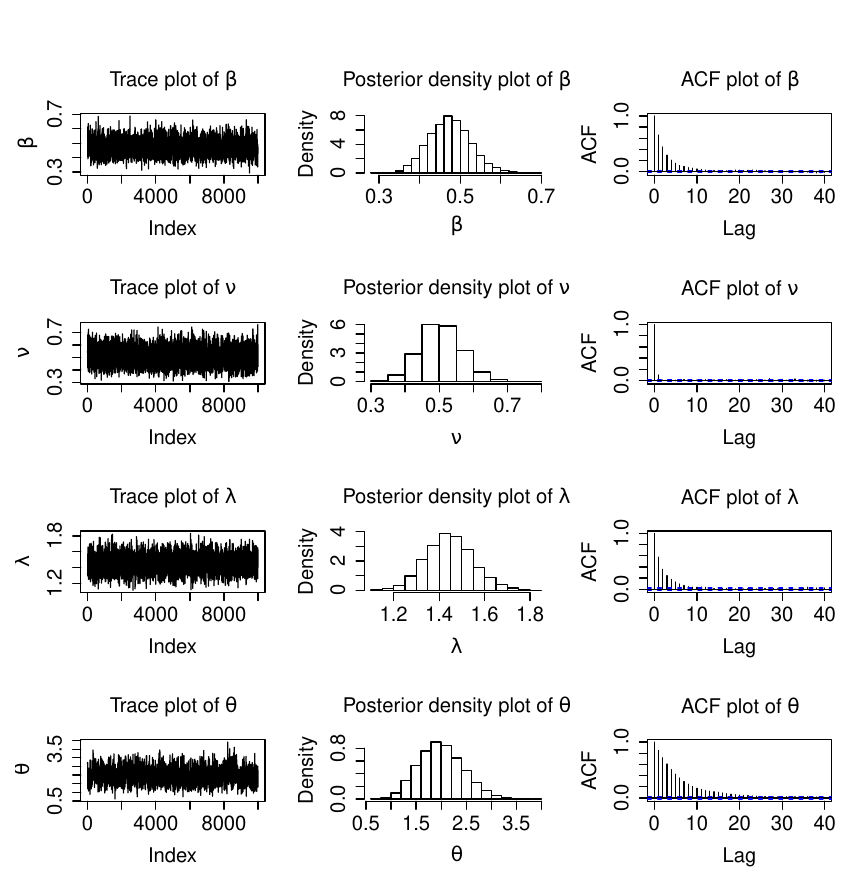
Figure 6 – MCMC diagnostic plots of the